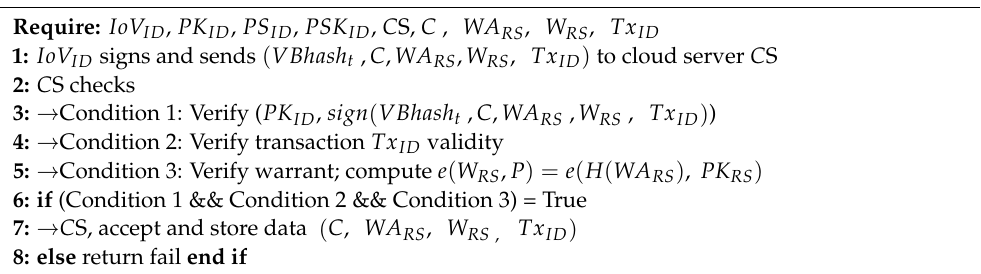
Algorithm 3: Outsourcing Data to the Cloud